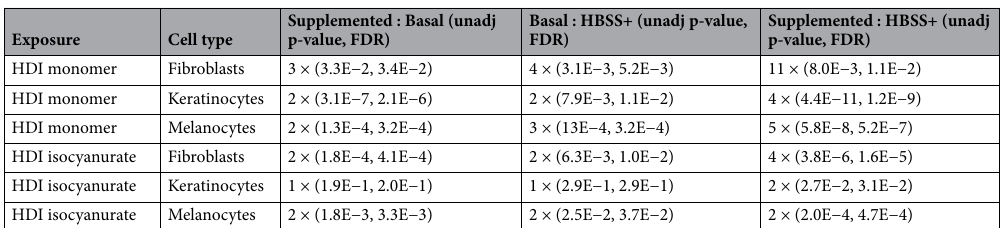
Table 2. Fold differences between the average LC 50 values in different media for each cell type and isocyanate exposure type.